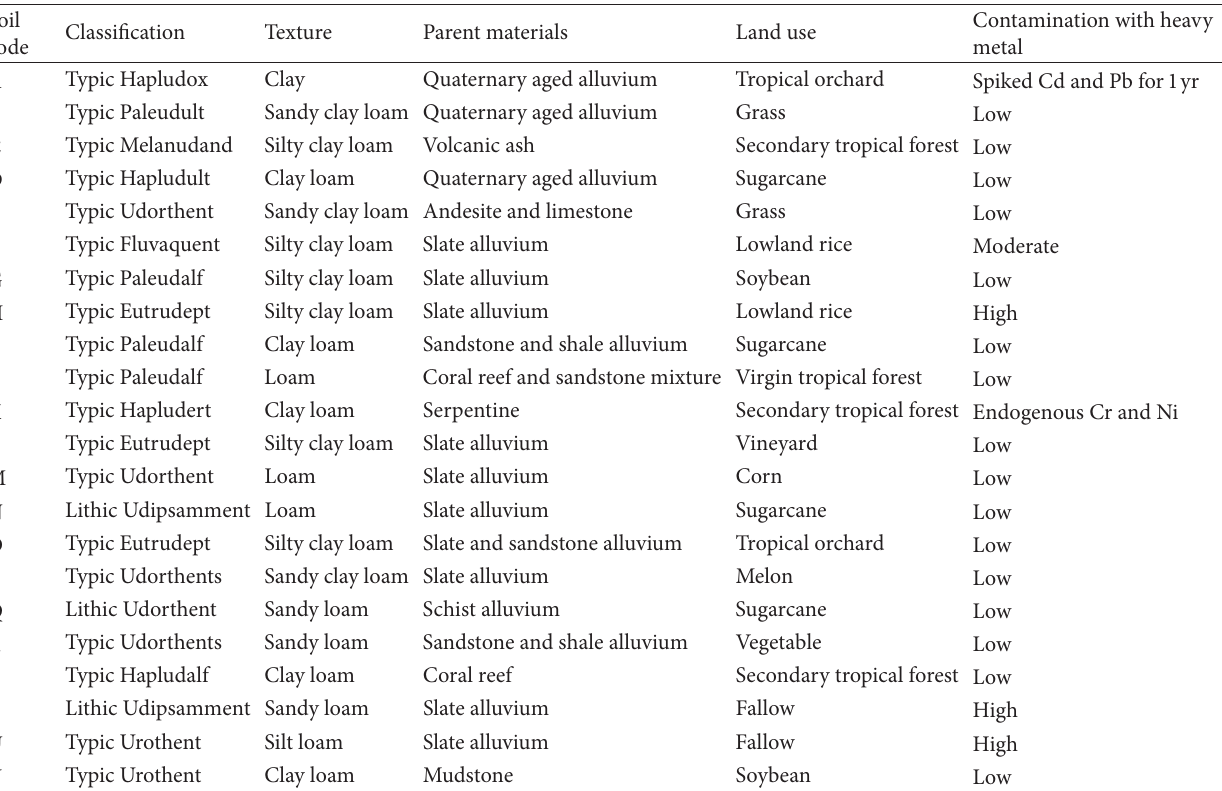
Table 1: Description of the studied soils.